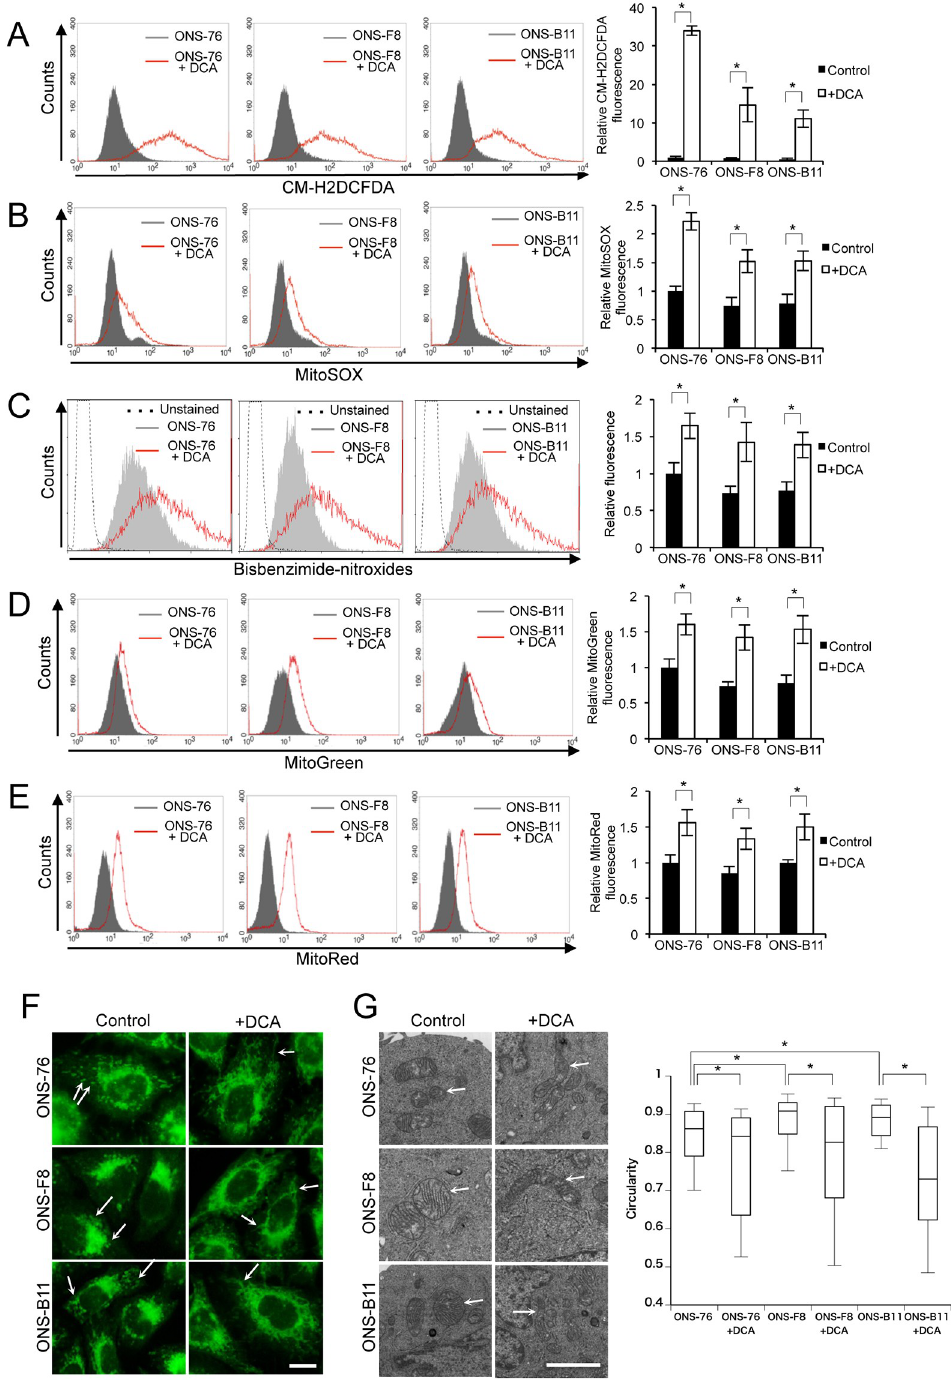
Fig 3. DCA enhanced ROS production and changed mitochondrial signature. (A) Intracellular ROS, (B) mitochondria-derivedsuperoxide, (C) nuclear oxidativestress, (D) mitochondria mass, (E) mitochondria membranepotential, (F) fluorescence microscopy with MitoGreen stain (scale bar 5 μ m), and (G) TEM analysisof mitochondria (scale bar 2 μ m) and mitochondrial circularity(at least 50 mitochondria were measuredfor each sample using ImageJ software) in ONS-76, -F8 and -B11 cells with and without DCA. White arrows indicate mitochondria. Quantitative data (without mitochondrial circularity) are means ± S.D. Quantitative data of mitochondrial circularityare shown as boxplots. * P < 0.05,Welch’s t-test.